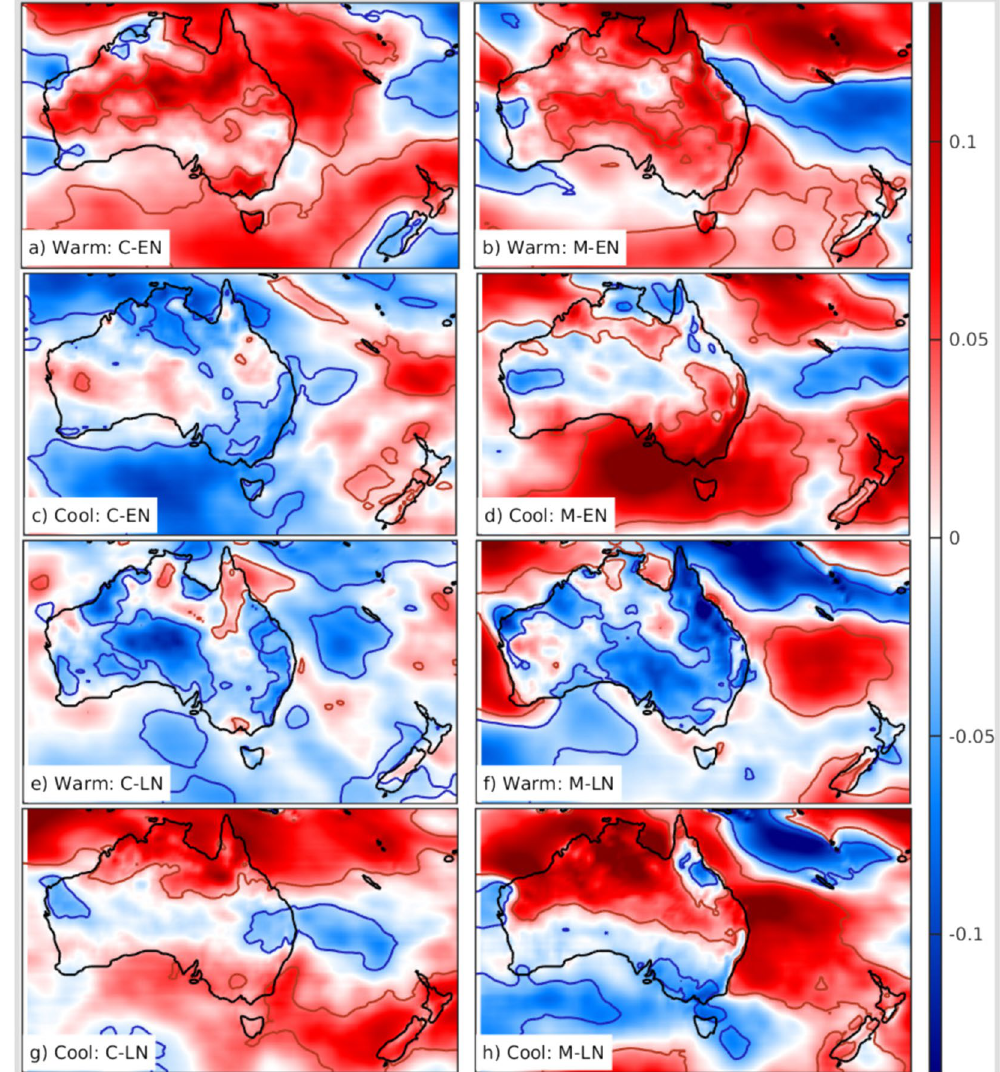
Figure 3. Seasonal composites of WPD anomalies: The mean standardized anomalies of WPD. The season and ENSO mode and phase are shown in the lower left corner of each panel. Red (blue) contours show regions with statistically significant increase (decrease) at 90% significance level. The unit along the colorbar is standard deviation. The figure including the map and all the text elements has been plotted in MATLAB version R2016a.